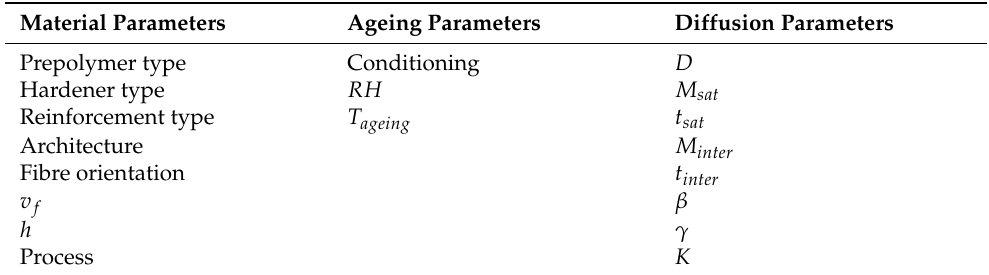
Table 11. List of variables used in the four classified principal component analysis. The 12 qualitative variables are in italics and the 7 quantitative variables in